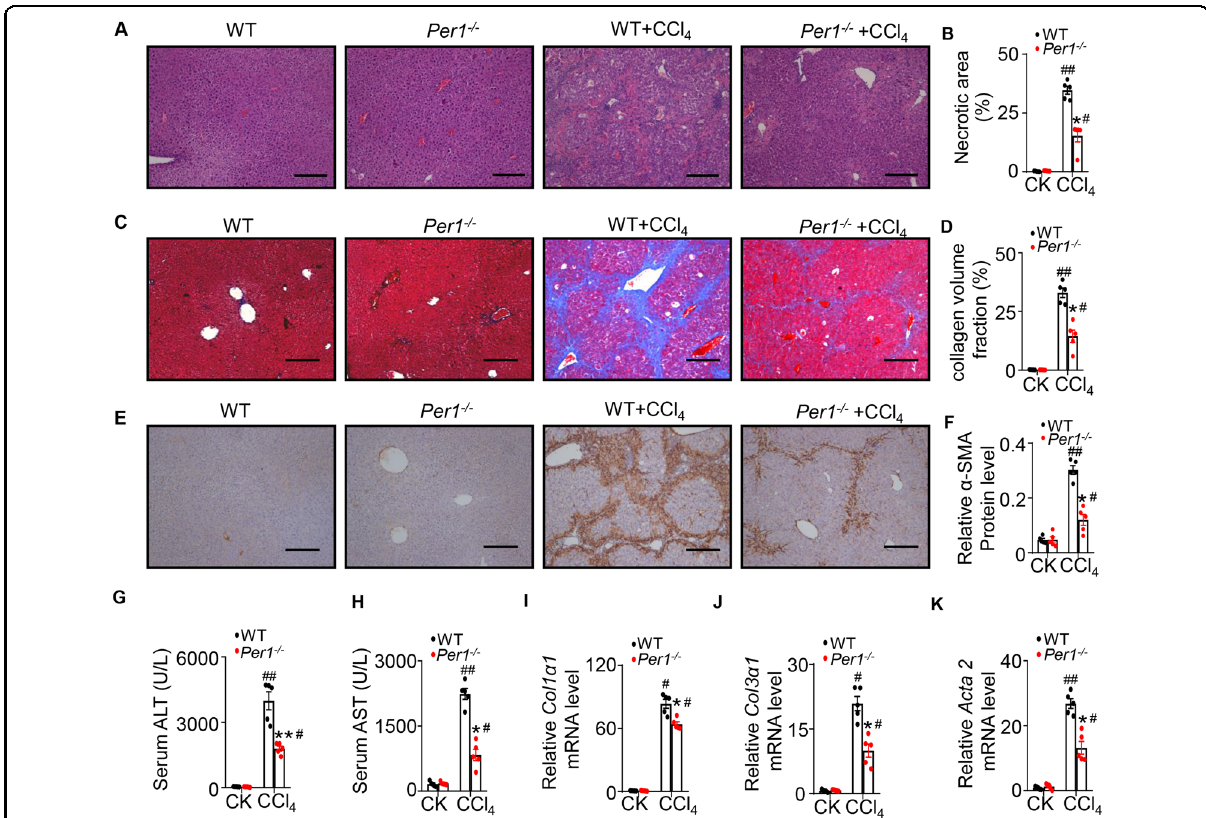
Fig. 4 Effect of Per1 de fi ciency on liver injury induced by chronic CCl4 administration. A H&E staining of livers from each treatment group. B The percentage of necrotic area was quanti fi ed using Image J software. C Masson ’ s trichrome of livers from each treatment group for the visualization of hepatic collagen deposition. D The percentage of collagen volume fraction was quanti fi ed using Image J software. E Expression of α -SMA was determined by immunohistochemistry. F Relative α -SMA Protein level was quanti fi ed using Image J software. Bar = 100 μ m. Representative images from N = 3 biological replicates. Serum activities of G ALT and H AST were measured after chronic CCl 4 administration. Relative mRNA levels of I Col1 α 1 and J Col3 α 1 were measured in the liver of WT and Per1 − / − mice. K Relative mRNA levels of Atca2 were measured in liver of WT and Per1 − / − mice. CK: control. Data were shown as means ± S.E.M. N = 5 independent biological replicates per group. * indicates P value <0.05, ** indicates P value <0.01, Per1 − / − group versus WT group; # indicates P value < 0.05, ## indicates P value <0.01, CCl 4 group versus control